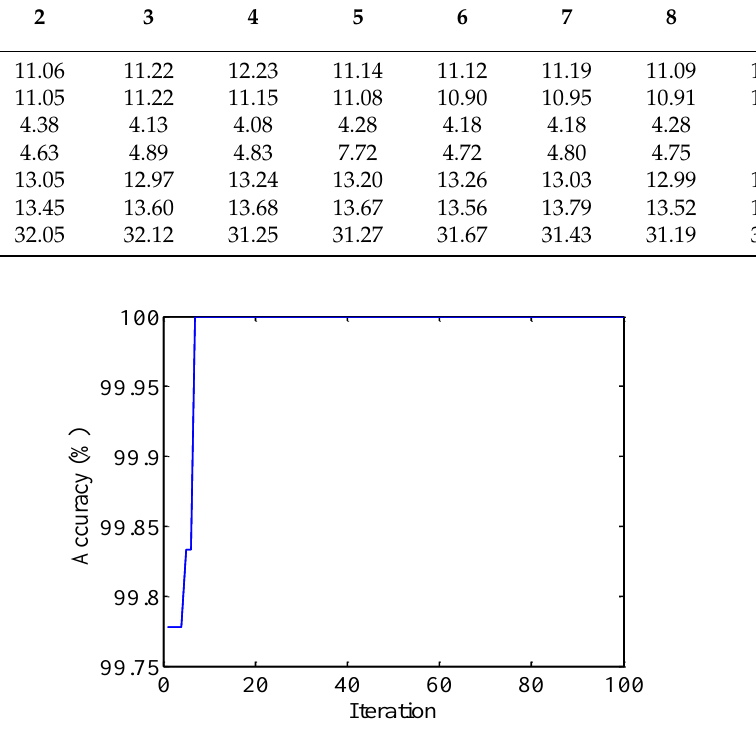
Figure 25. Classification accuracy with BO. Table 6. The range and results of hyperparameter optimization.